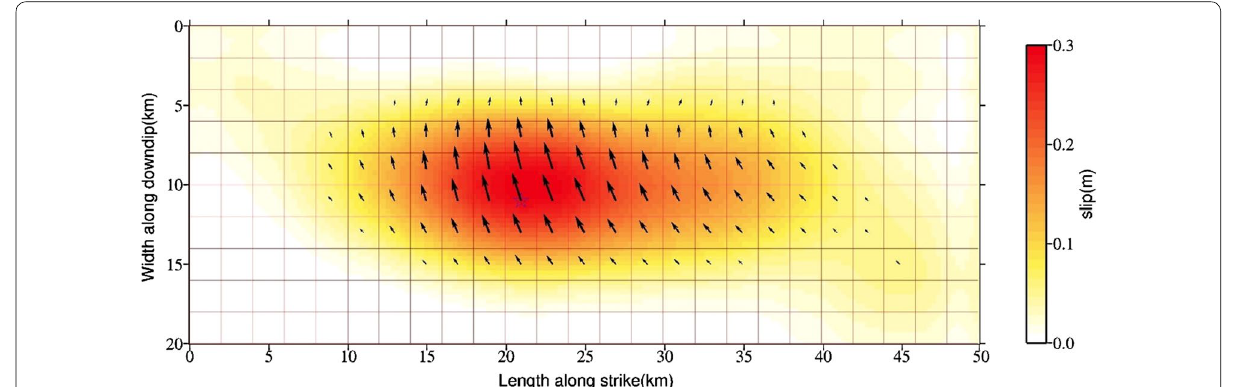
Fig. 3 Coseismic slip model of the Jiashi earthquake